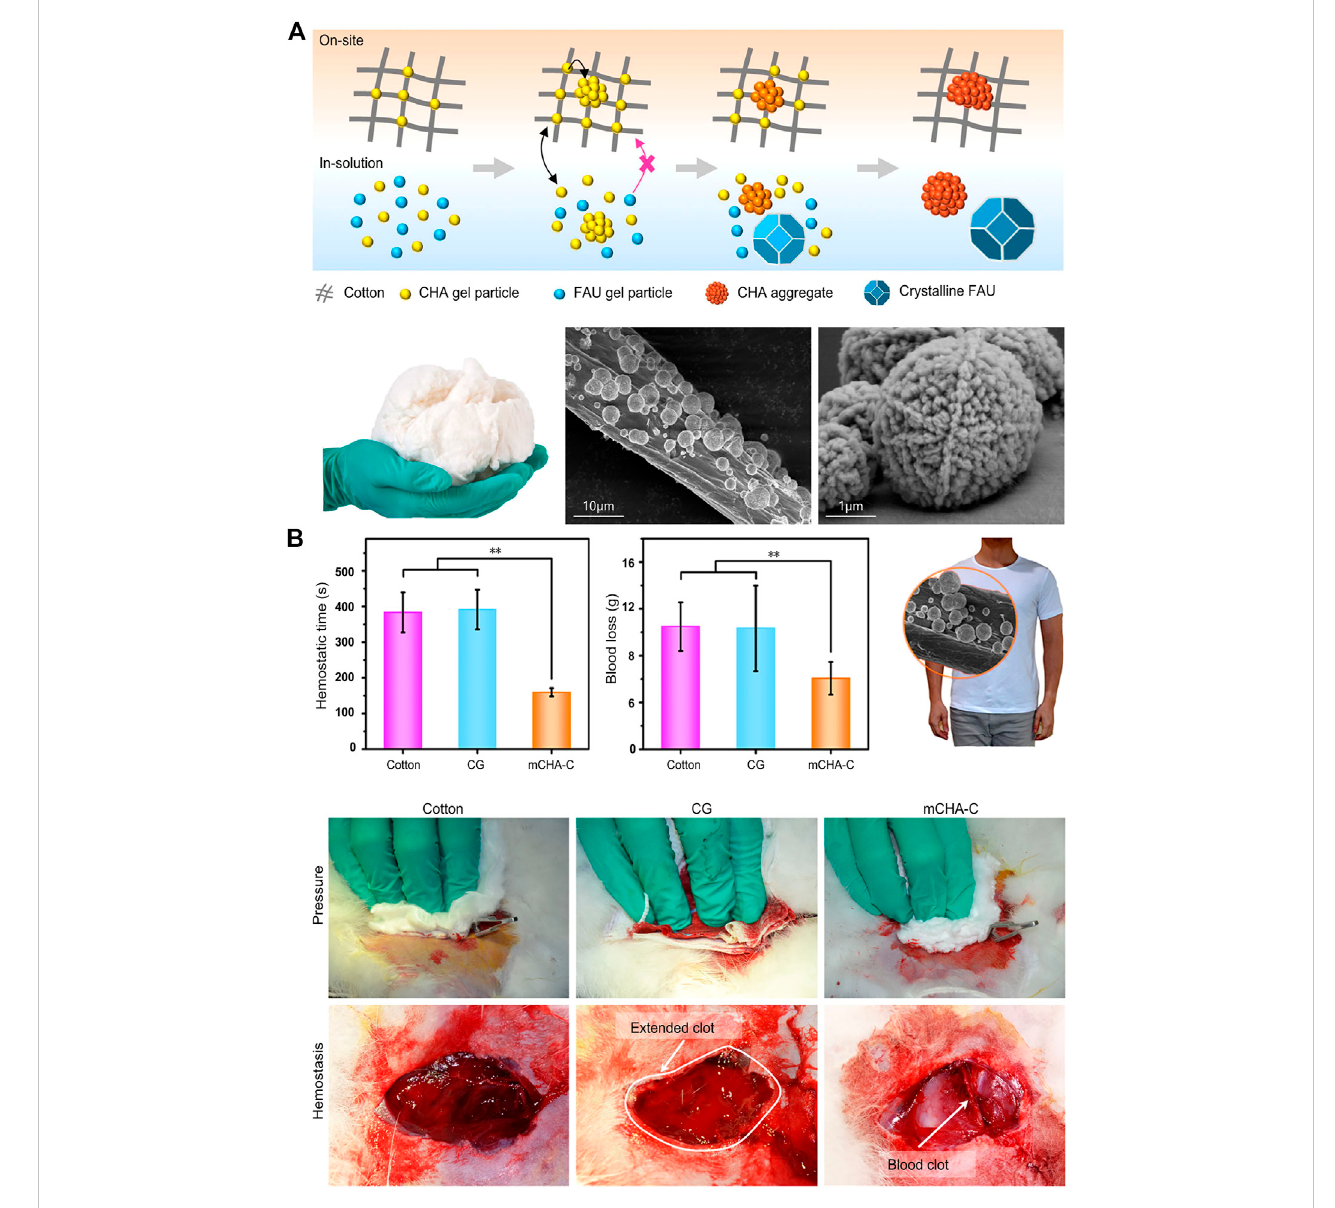
FIGURE 1 Inorganicbiomaterialsappliedinhemostasis. (A) Upper:theschematicrepresentation offormationprocessofon-siteandin-solutionproducts (Yuetal., 2019). Left: the photograph of mCHA-C. The SEM images of (Middle) mCHA-C, (Right) mCHA zeolite on cotton. (B) In vivo hemostatic capacity evaluation of hemostats. The quantitative analysis of hemostatic time (left) and blood loss (middle) in the rabbit femoral artery injury model. Right: Image of